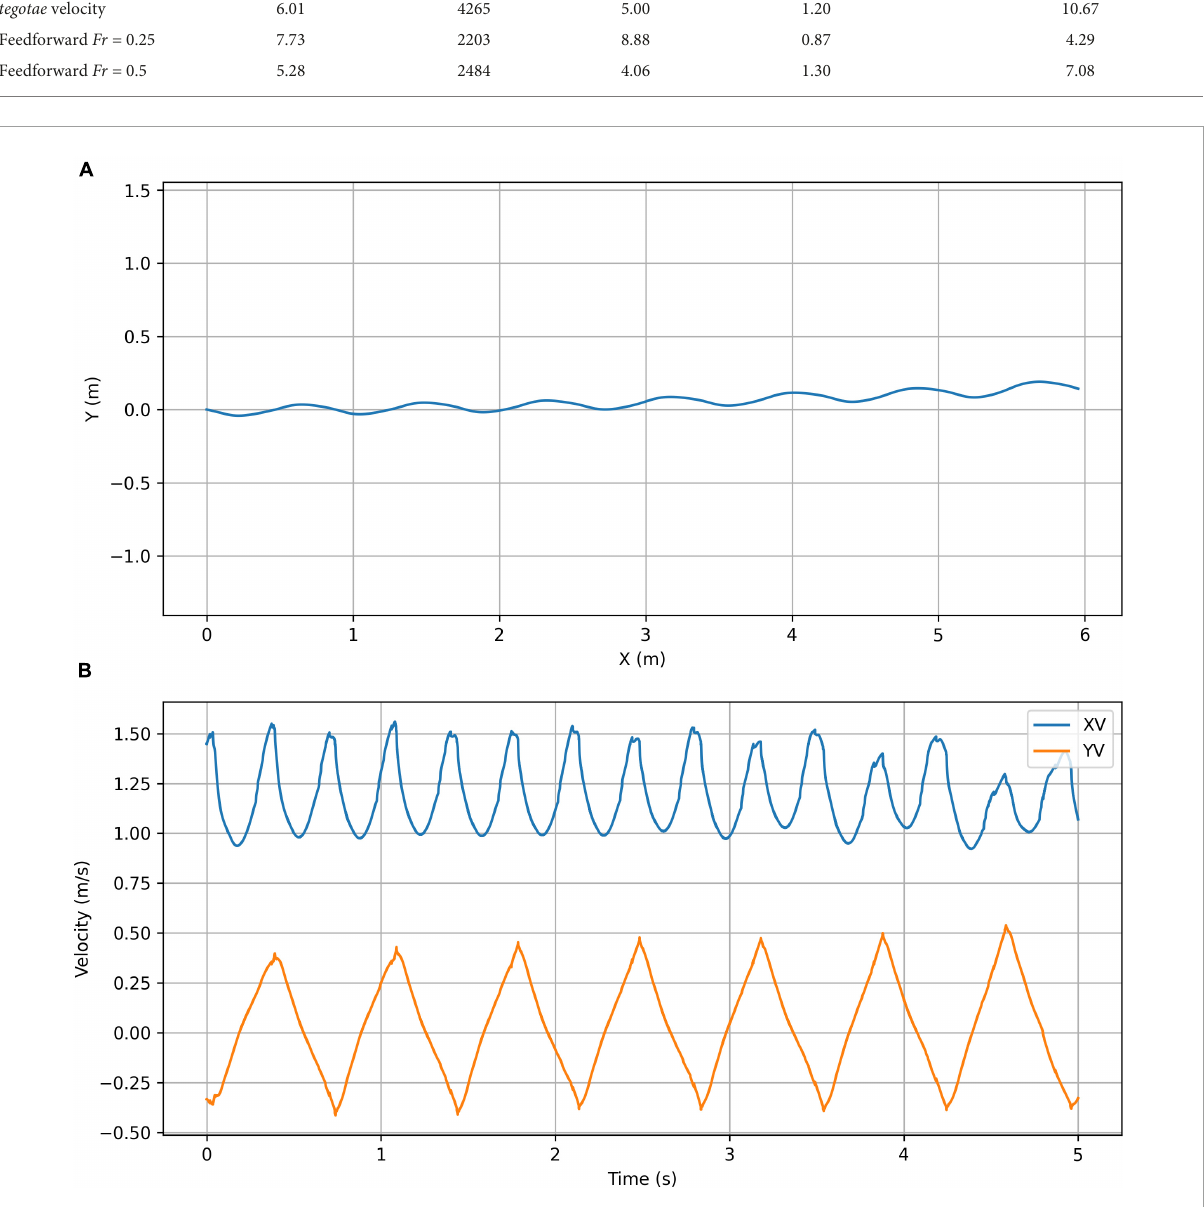
FIGURE7 Optimized for forward velocity simulation plots. (A) Trajectory plot showing the top view of the path taken by the center of mass of the chimpanzee’s torso. (B) Velocity plot showing the X (forward) velocity and Y (lateral) velocity of the center of mass of the chimpanzee’s torso.